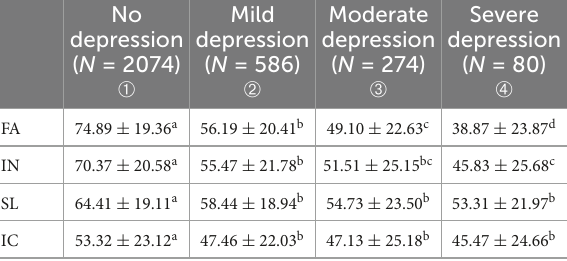
TABLE 2 Comparison of standardized scores of each subscale of SSFD among different severity levels of SDS (mean ± SD). No depression